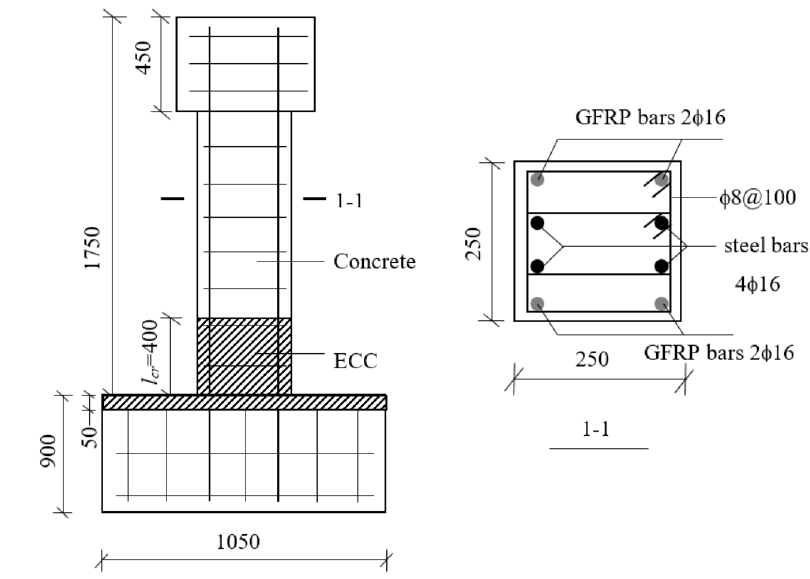
Table 1. Mixture proportions.